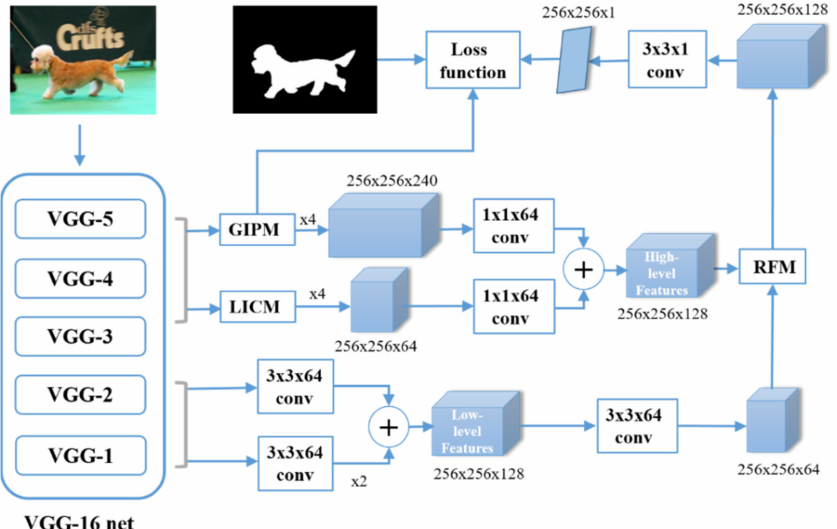
Figure 1. The pipeline of the proposed approach. LICM: local information concatenation module. GIPM: global information perception module. RFM: refinement fusion module. x2, x4: upsampling. VGG-1, VGG-2, VGG-3, VGG-4 and VGG-5 correspond to the second, fourth, seventh, tenth and thirteenth layer of VGG-16,